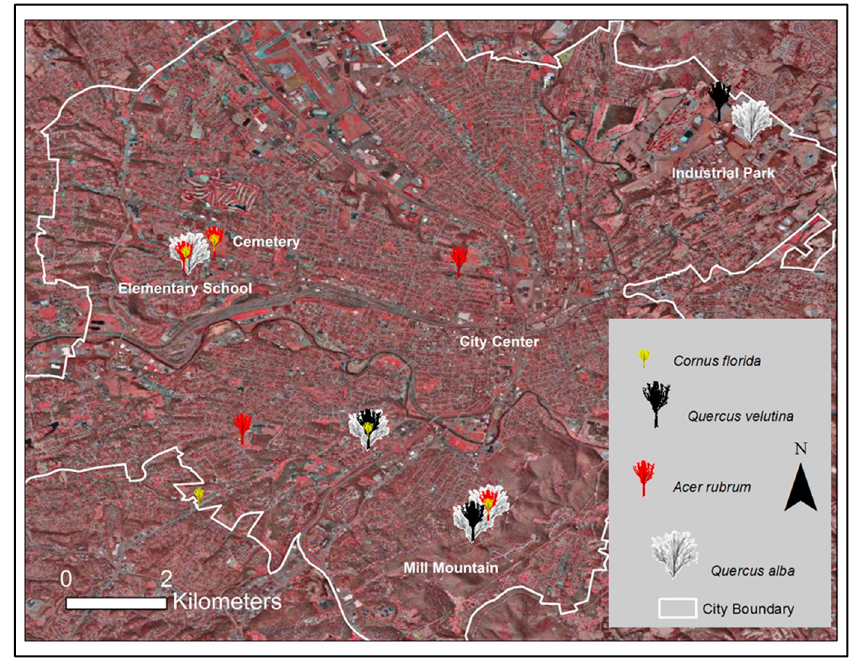
Figure 6. Locations of trees monitored by citizen scientists and reported in this study, superimposed on a color-infrared aerial image from the Virginia Base Mapping Program (imagery acquired 2011 with 6 inch resolution).